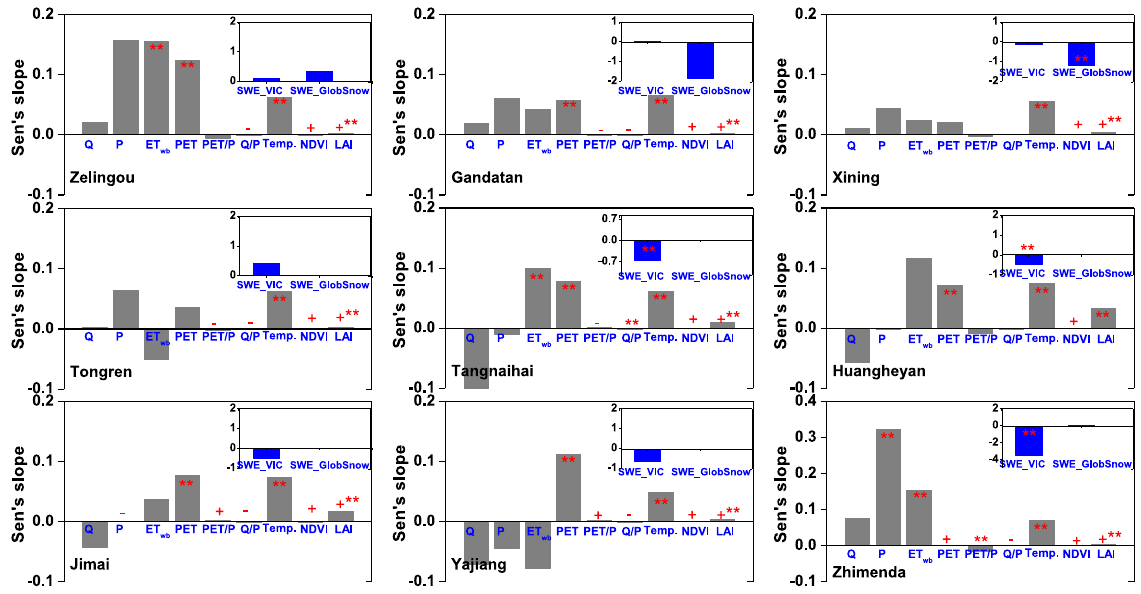
Figure 10. Similar to Fig. 8 but for east-Asian-monsoon-dominated TP basins. It should be noted that the GlobSnow data are not available for some basins. The double red stars showed that the trend was statistically significant at the 0.05